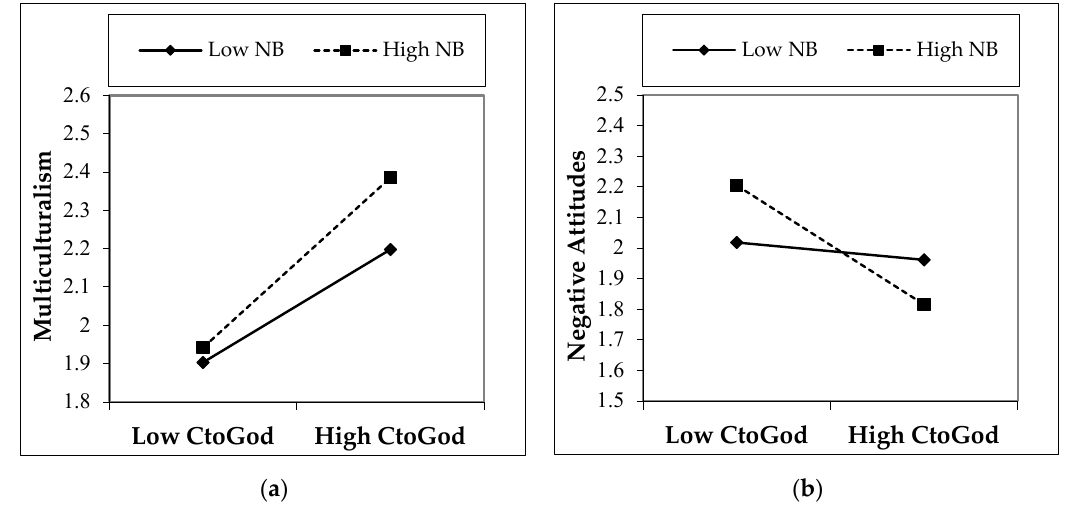
Figure 2. Interaction effect of CtoGod and NB on multiculturalism ( a ) and negative attitudes ( b ).